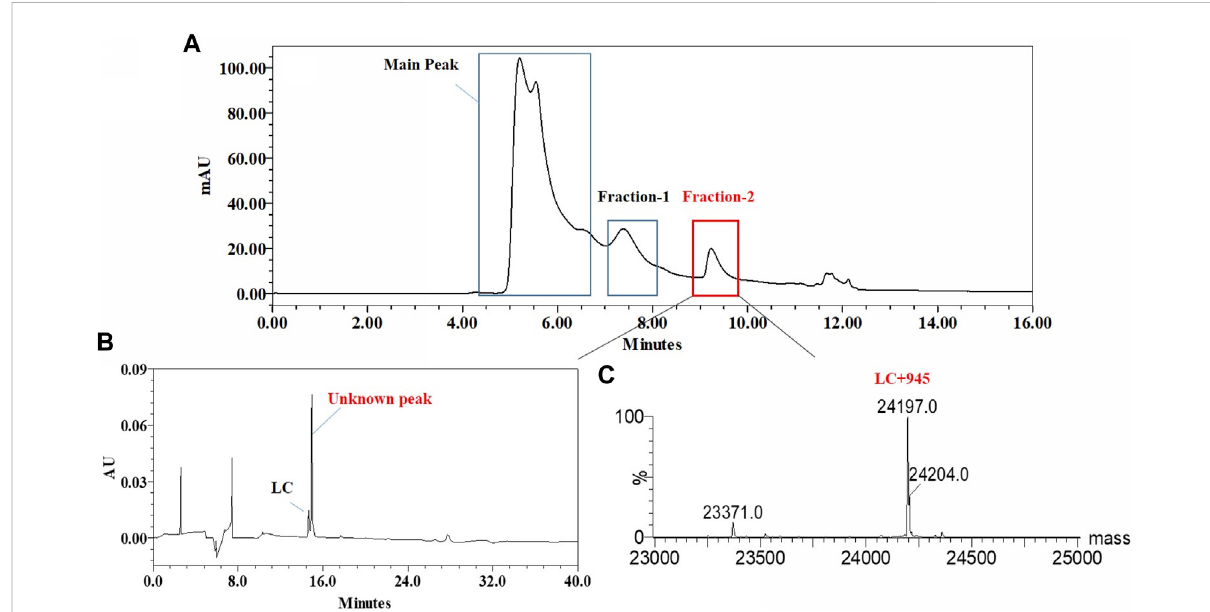
FIGURE 3 Fraction and identi fi cation of LC related Peaks. (A) : LC related peaks (Fraction-2) of Cell Pool 2 were fractioned by denaturing SEC-HPLC; (B) : nrCE-SDS pro fi le of fractioned peaks, high level of near-LC unknown peak in e-gram was observed; (C) : deconvoluted mass of Fraction-2, the detected mass was about 945 Da higher than the theoretical value of